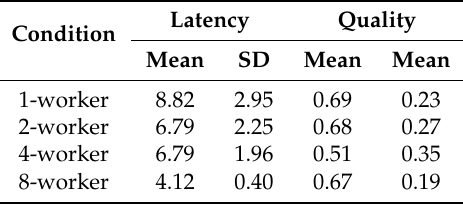
Table 5. Mean latency and quality scores for all conditions.